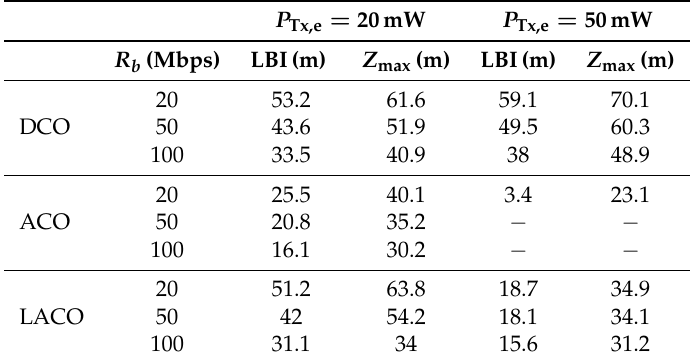
Table 5. LBI and maximum attainable range for DCO, ACO, and LACO-OFDM according to Figure10; BER = 10 − 3 , η ≈